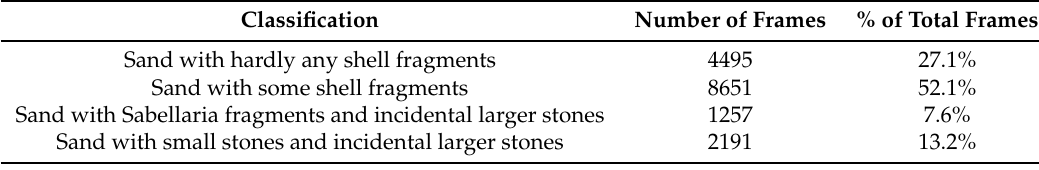
Table 1. Classification of video data with numbers and percentages of total frames per class.